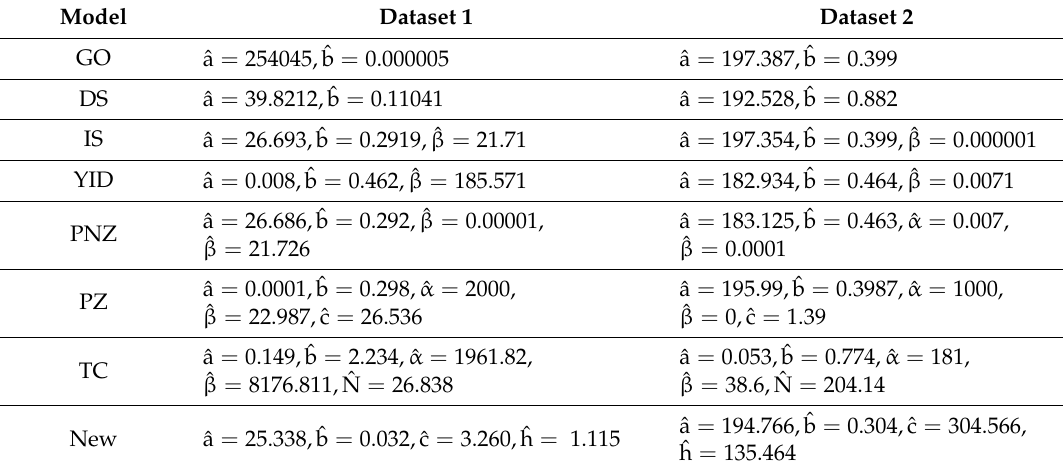
Table 3. Estimation of parameters for